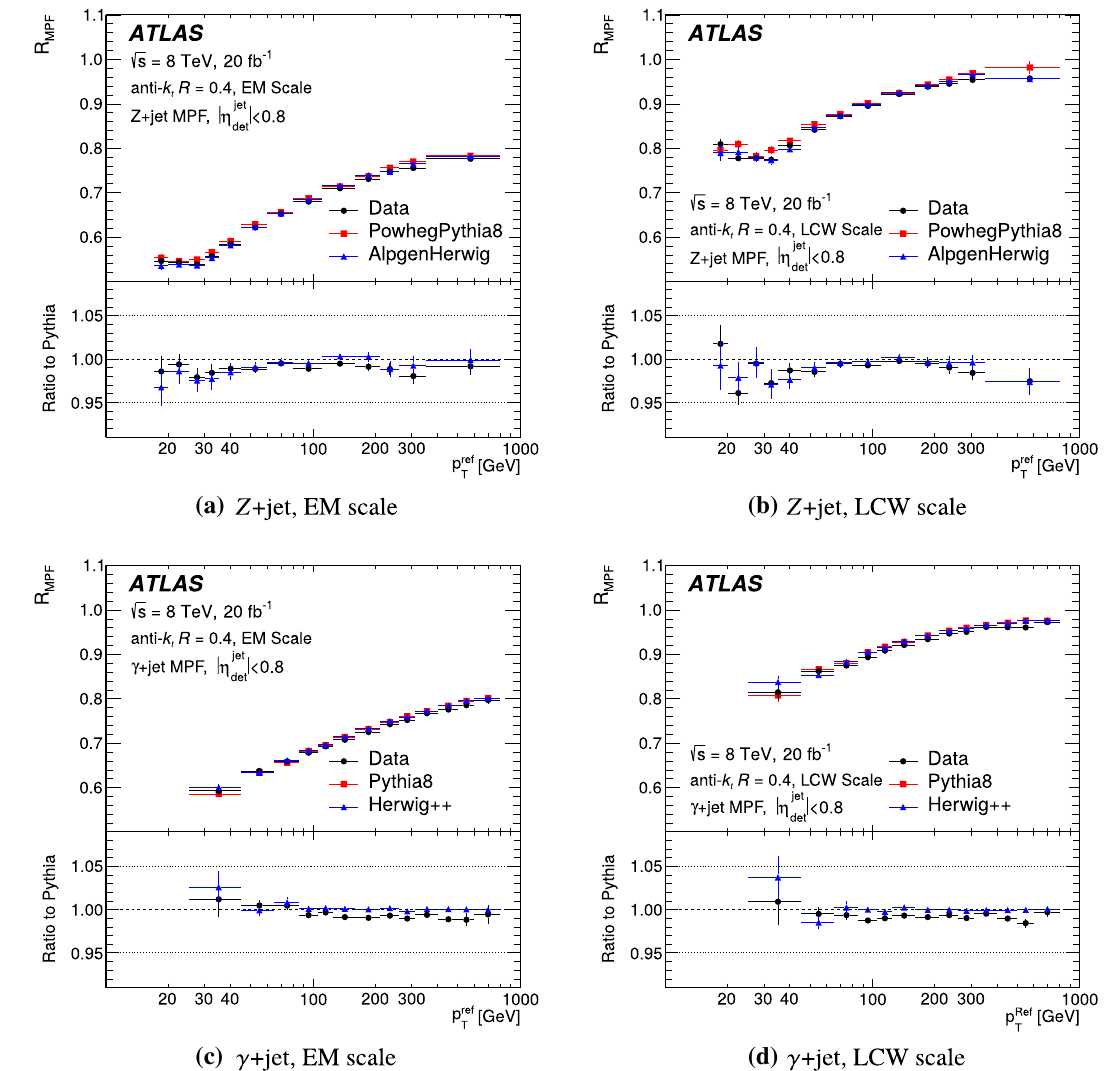
Fig. 24 The MPF response R MPF in a , b Z +jet and c , d γ +jet events for jets calibrated a , c at the EM scale and b , d using the LCW scheme, for both data and MC simulation, as a function of p ref . Only statistical uncertainties are T